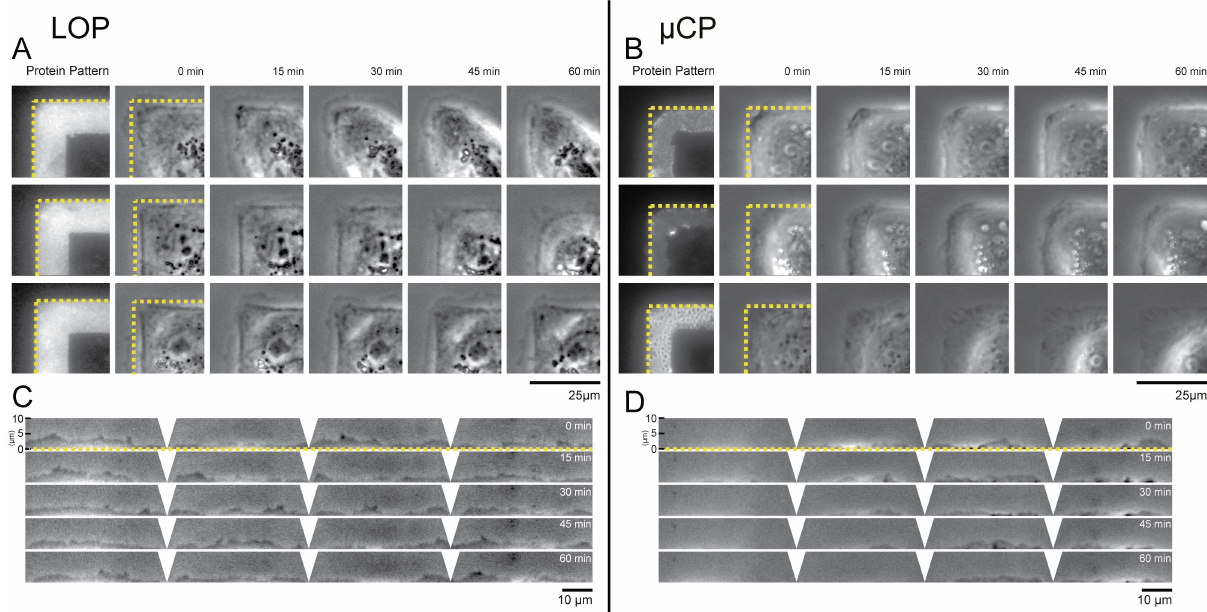
Fig 5. Lamellipodia are more exploratory for cells on LOP than on μ CP patterned substrates. Phase contrast time lapse imagingof 3 representative MDCK cells on 25 kPa PAAm gels patternedby LOP (A) and μ CP (B). Cellson substrates producedby LOP follow the protein pattern bordermore accurately(dotted line panelsA, B) and revealmore pronounced lamellipodia. (C, D) Kymographanalysisof lamellipodia kineticsalongpattern edge. Singlecell on LOP pattern shows increased lamellipodia protrusionsand retractions within a 10 μ m wide regionof interest outside the proteinpattern edge compared to a cell on a μ CP pattern (S5 and S6 Movies). Kymographsshow cells depicted in bottom row of panel A and B. Regionsof interest are straightened and distortedregionsat the pattern corners are cleared.